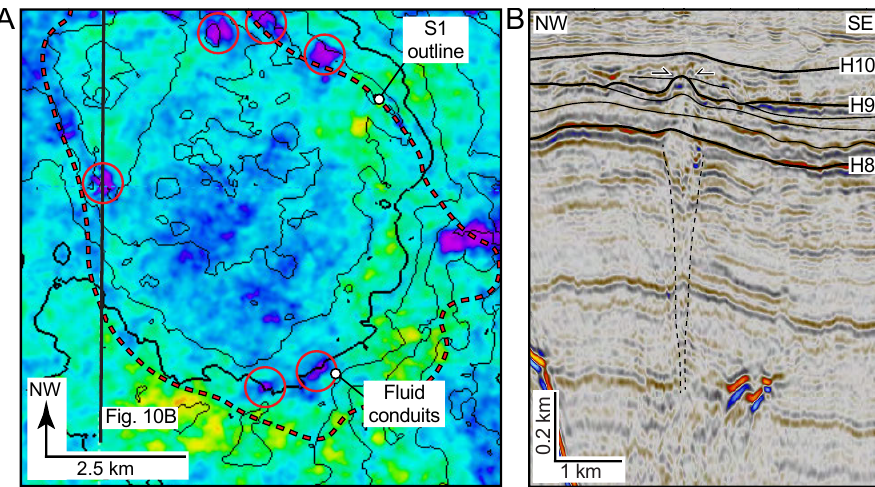
Figure 10: [A] Root mean squared (RMS) amplitude map of H8 over S1. Warm colours correspond to areas of high amplitude, whereas cold colours are areas of low amplitude. Hydrothermal vent conduits are highlighted by the red circles. [B] Interpreted seismic section showing a hydrothermal vent, onlapped by overlying strata, and underlain by a pipe-like zone of disturbed reflections. See Figure 10B for location. area relative to the boreholes implies the velocities used are minimum end-members; and/or (iii) multiple, seis- mically undetectable sills (i.e. <7 m thick) contributed to fold generation.